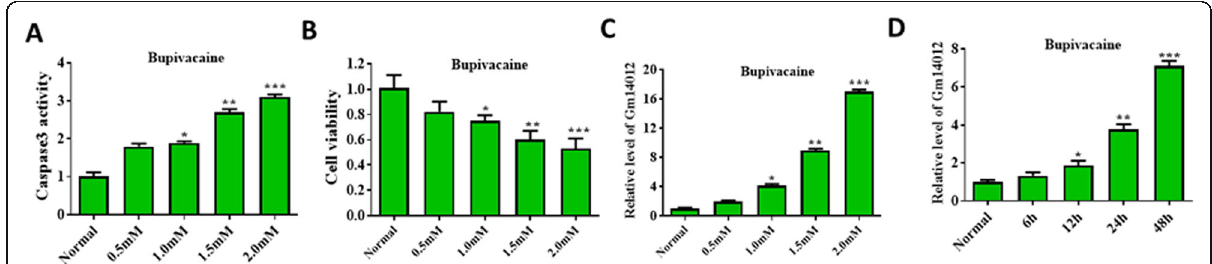
Fig. 1 Expression of lincRNA Gm14012 in bupivacaine-induced neurotoxicity. a Caspase3 activity of DRG neurons was significantly upregulated with the elevation of concentration of bupivacaine. Mean values: 1.5 mM b Cell viability of DRG neurons was significantly decreased with the elevation of concentration of bupivacaine. c The expression of lincRNA Gm14012 was significantly upregulated with the elevation of concentration of bupivacaine. d The expression of lincRNA Gm14012 was significantly upregulated with the extension of bupivacaine treatment. Data are Mean ± SD with n = 3 independent biological cultures. * p < 0.05 and ** p <